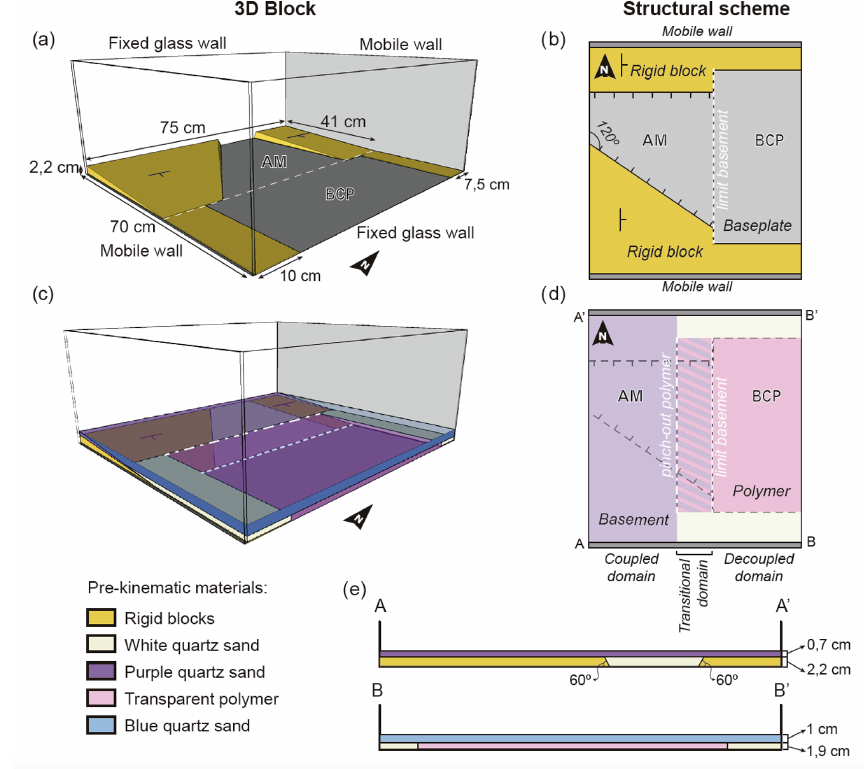
Figure 3. 3D blocks (left) and overhead sketches (right) of the experimental set-up. (a) 3D block showing the distribution of the rigid blocks at the base of the model. (b) Overhead sketch of the previous 3D block. (c) Final experimental configuration before extensional deformation showing the distribution of the different layers. The limit of the basement and the pinch-out of the polymer are also indicated (see Fig. 3d for legend). (d) Overhead sketch showing the distribution of basement sand and polymer indicating the overlapping area and the boundaries of both units, which defines the different structural domains. (e) Cross-sections of the coupled and decoupled domains prior to extension. See Fig. 3d for location. AM (Asturian Massif) and BCP (Basque–Cantabrian Pyrenees) represent the modelled analogue domains in